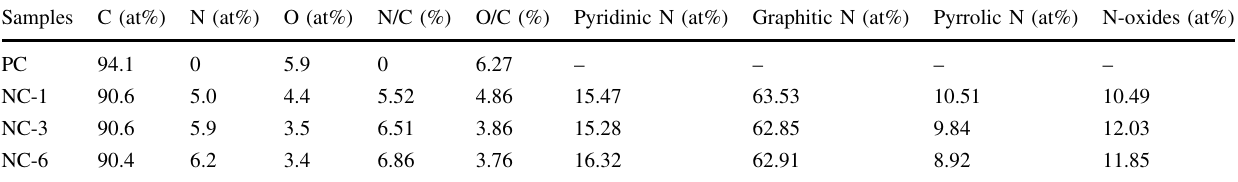
Table 1 C, O, and N content, the ratios of N/C and O/C, and relative nitrogen species analyzed by N 1 s XPS spectra of pure PC and NC-X samples Samples C (at%) N (at%) O (at%) N/C (%) O/C (%) Pyridinic N (at%) Graphitic N (at%) Pyrrolic N (at%) N-oxides (at%)